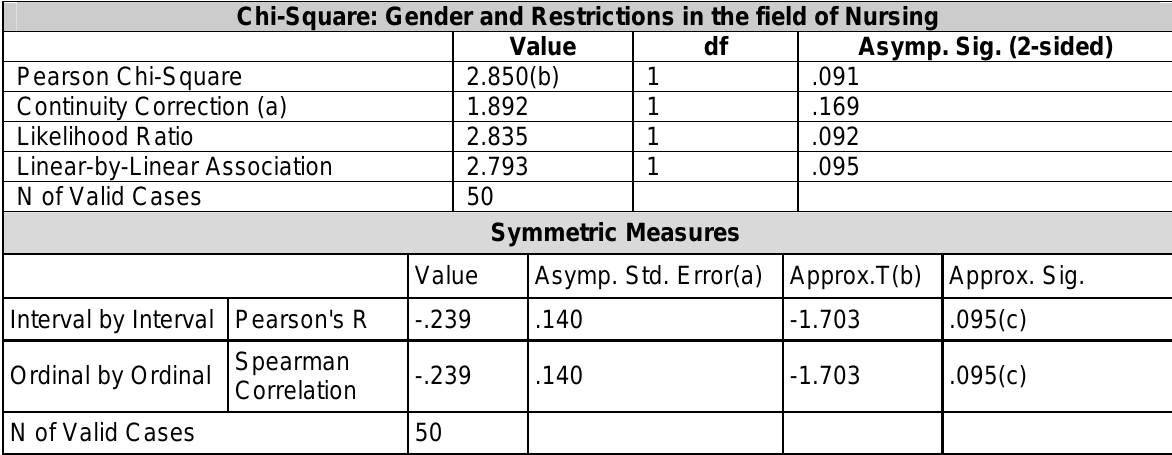
Table 1: Gender and restrictions in the nursing field Chi-Square: Gender and Restrictions in the field of Nursing Value